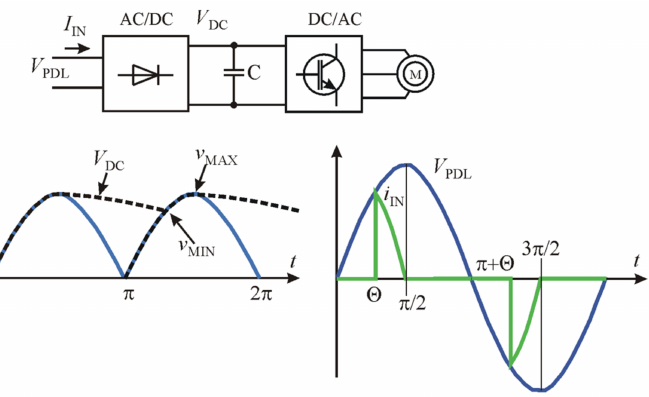
Figure 2. Time diagrams of the voltage and current of single-phase diode rectifier supply-side